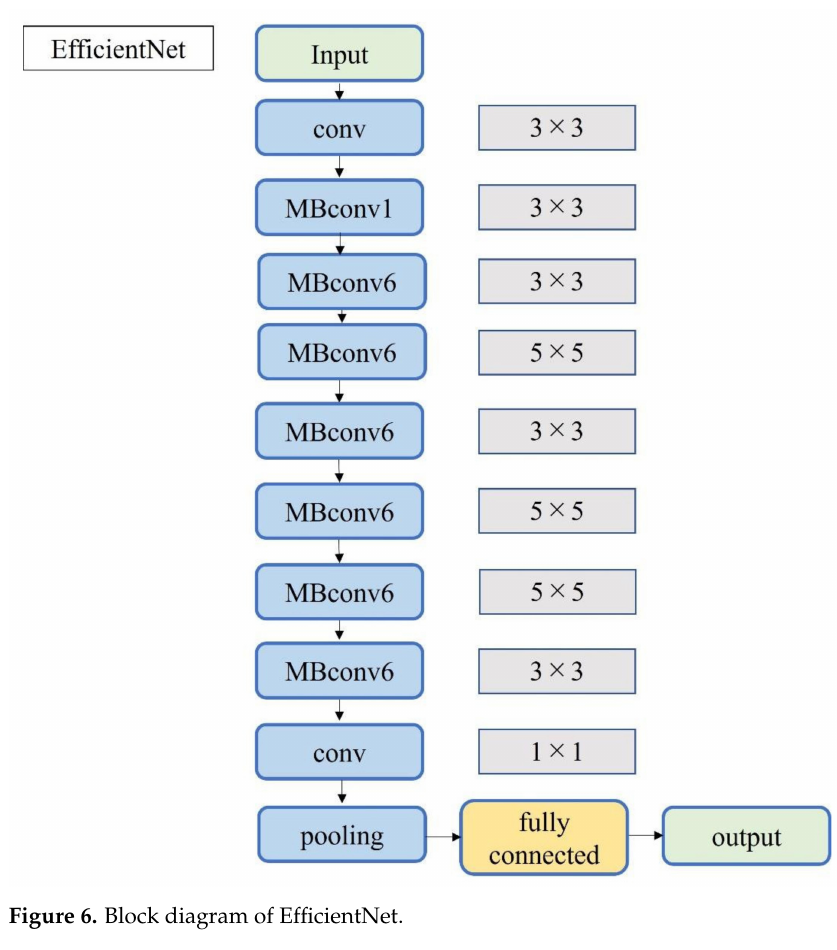
Figure 6. Block diagram of EfficientNet.